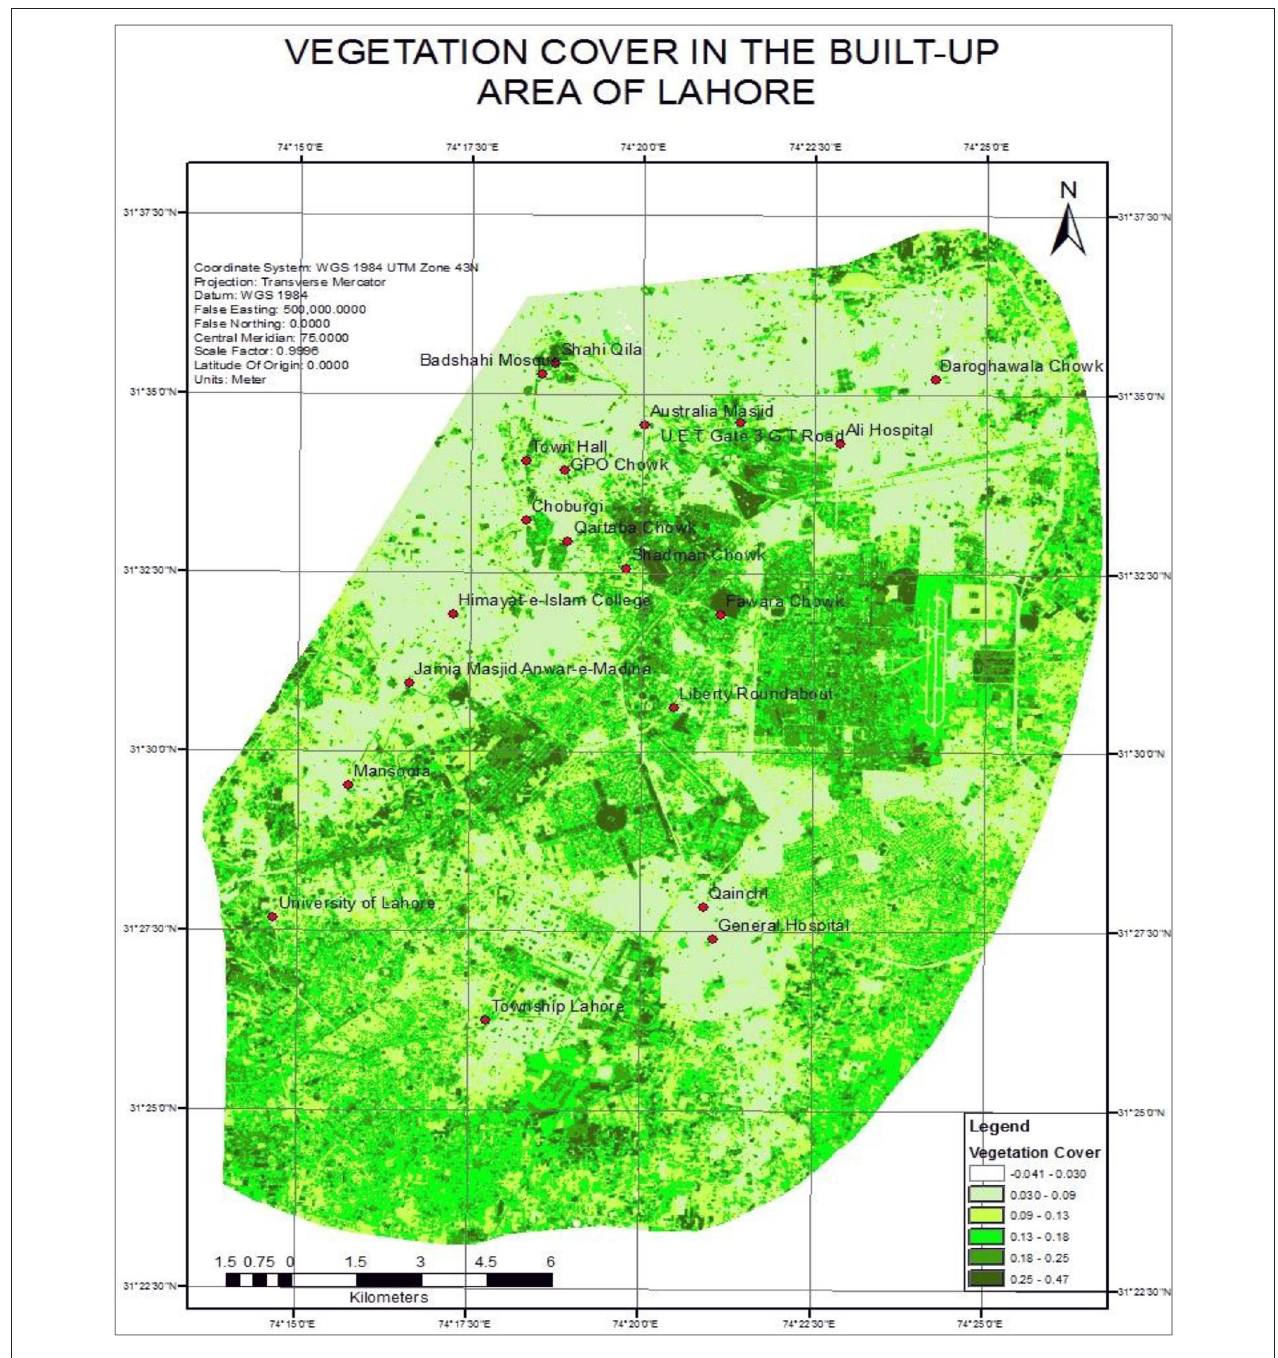
FIGURE 2 | Vegetation cover in the built-up area of Lahore.